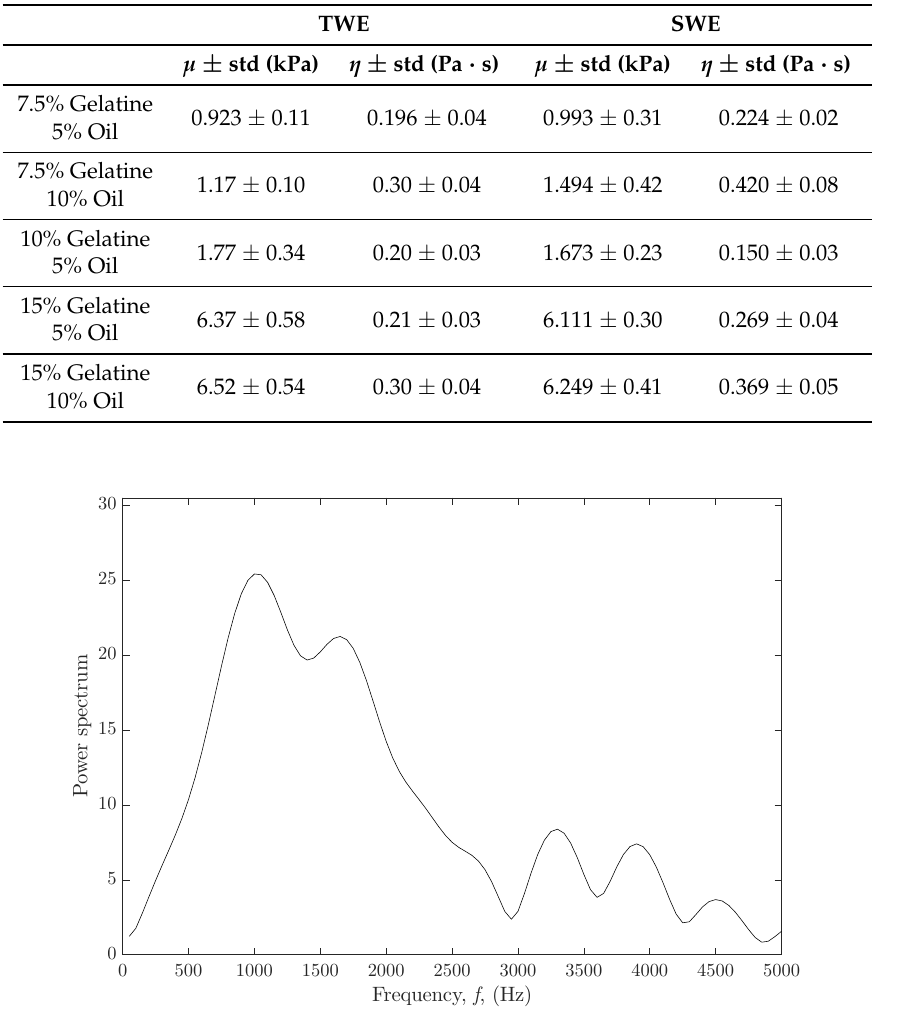
Table 8. Kelvin Voigt parameters from TWE versus Verasonics for each batch of gelatine.